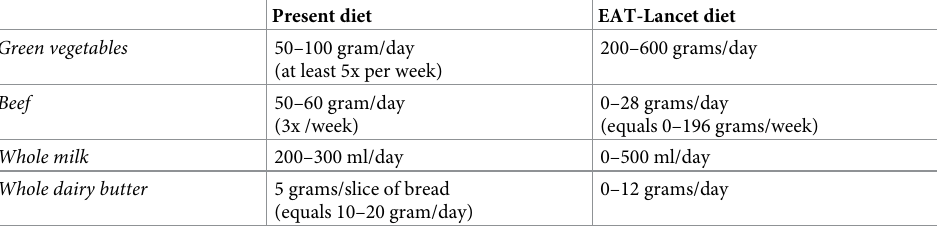
Table 1. Components of the dietary advice of the present study compared to the EAT-Lancet diet. Present diet EAT-Lancet diet Green